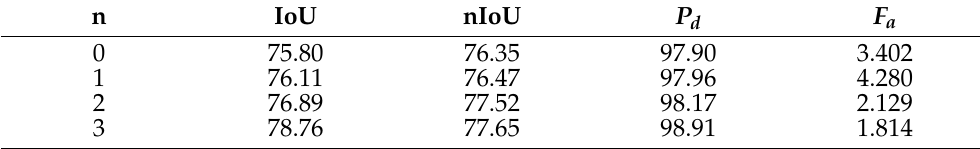
Table 3. Ablation study of number of HLF blocks (n) for the IoU (%), nIoU (%), P d (%), and F a (10 − 5 ). n